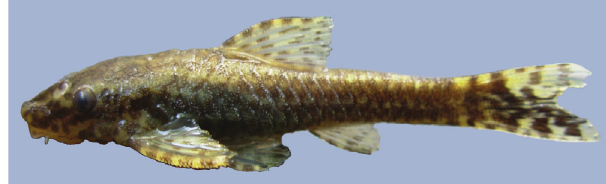
Fig. 4. Life coloration of Otothyropsis piribebuy , female